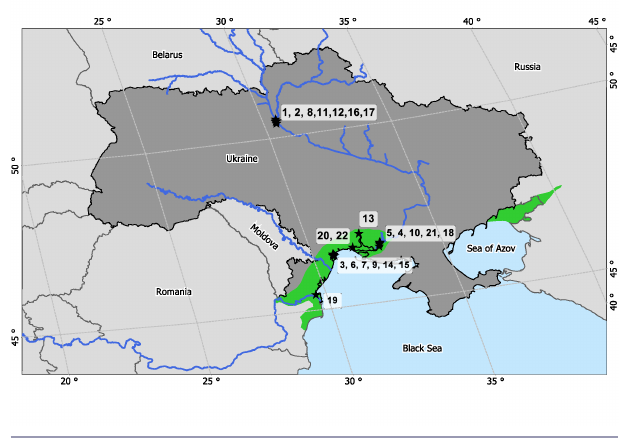
Fig. 1 . Study area. Black stars represent the stakeholder institutions (IDs in Table 1). Green areas indicate major Pontocaspian